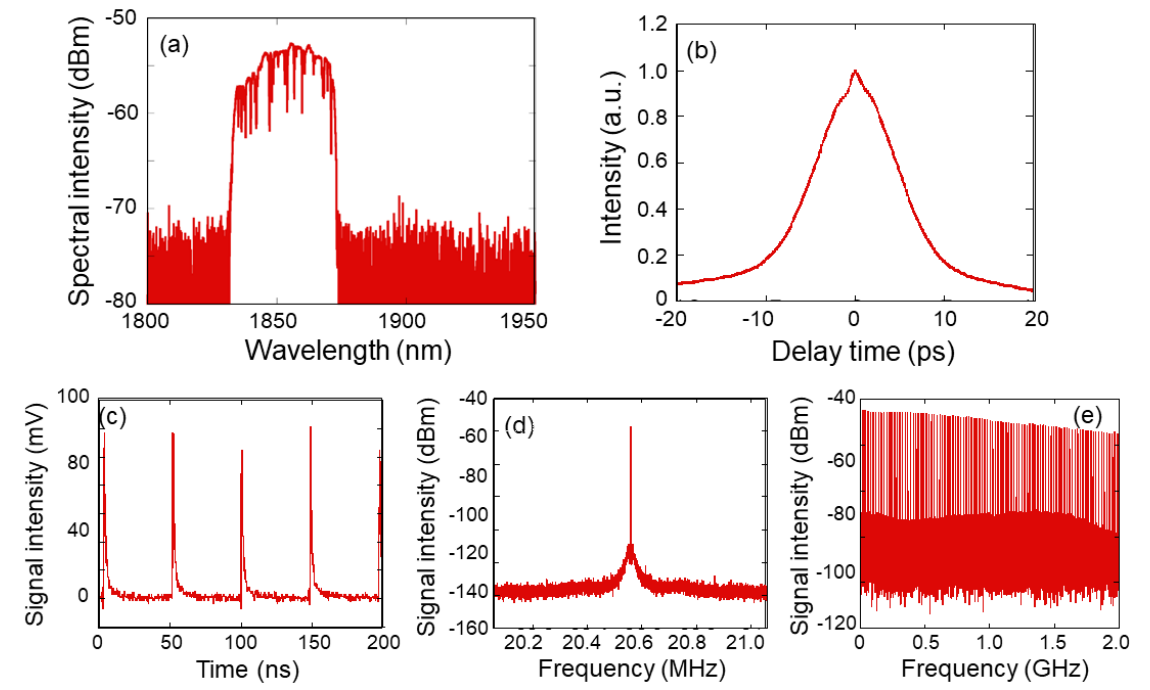
Figure 9. Characteristics of output pulses when D = +0.0503 ps 2 and spectral filter was used, ( a ) optical spectra, ( b ) autocorrelation trace, ( c ) pulse train, ( d , e ) RF spectra of ( d ) fundamental frequency and ( e ) wide range.